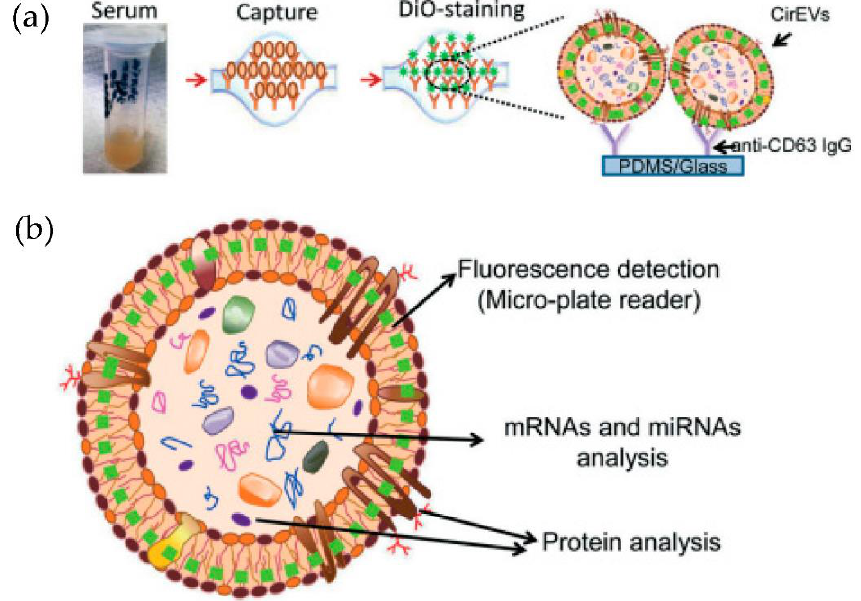
Figure 11. Experimental strategy for exosome immobilization and characterization using ExoChip ( a ) Schematic of exosome capture and analysis used in ExoChip. ( b ) Schematic for CirEVs fluores- cence detection in micro-plate readers. (Reproduced from Kanwar S.S. et al. [76]. Copyright 2014, Lab Chip).